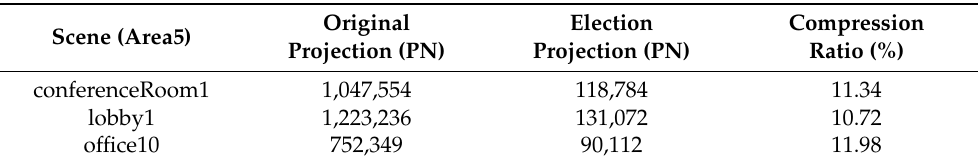
Table 1. Comparison of point numbers before and after dataset scene point cloud mapping in S3DIS (PN = Points